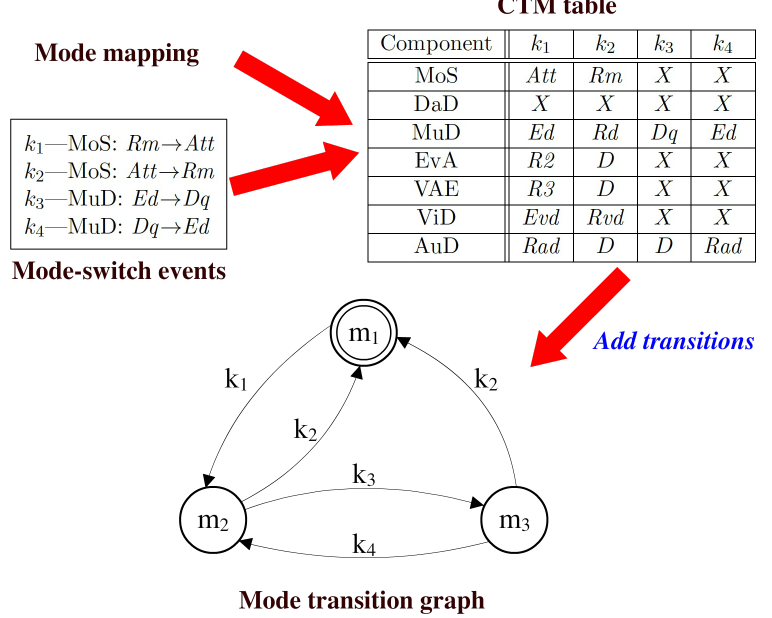
Figure 11. Deriving the mode transition graph of the monitoring subsystem. CTM, component target